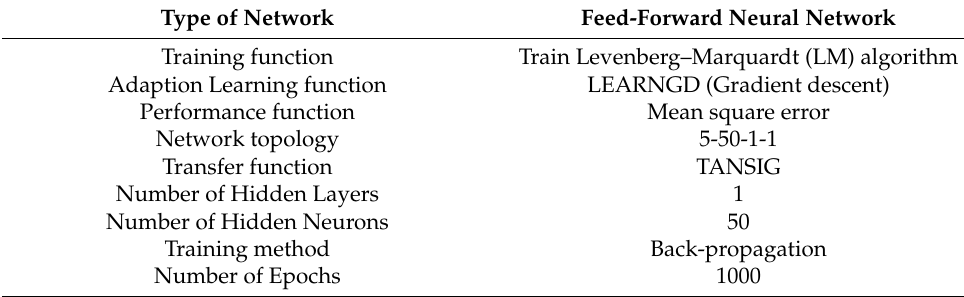
Table 6. Learning parameters designated for the ANN.